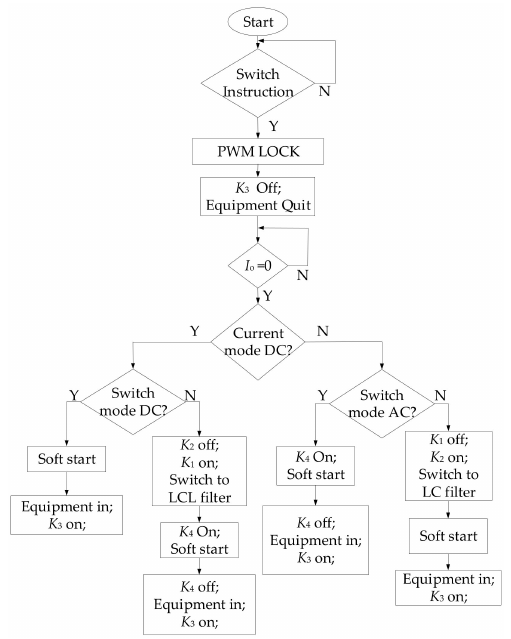
Figure 9. Switching Process among di ff erent modes.